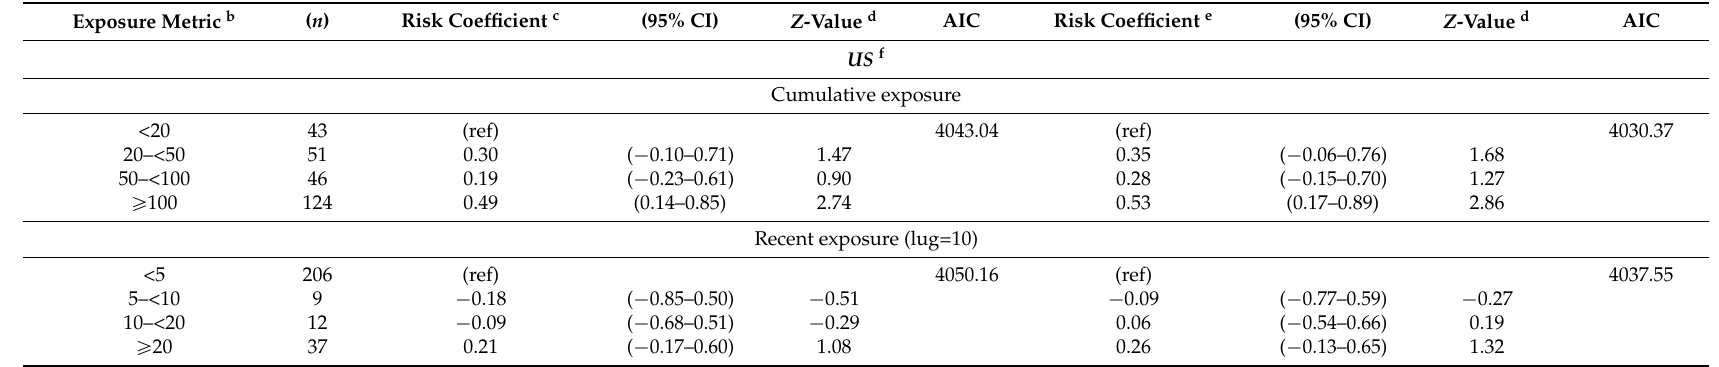
Table 10. Risk coefficients for acute myocardial infarction a obtained from Cox regression (internal analysis) and based on categories of estimated carbon black exposure in three full cohorts (US, UK, Germany; 432 observed